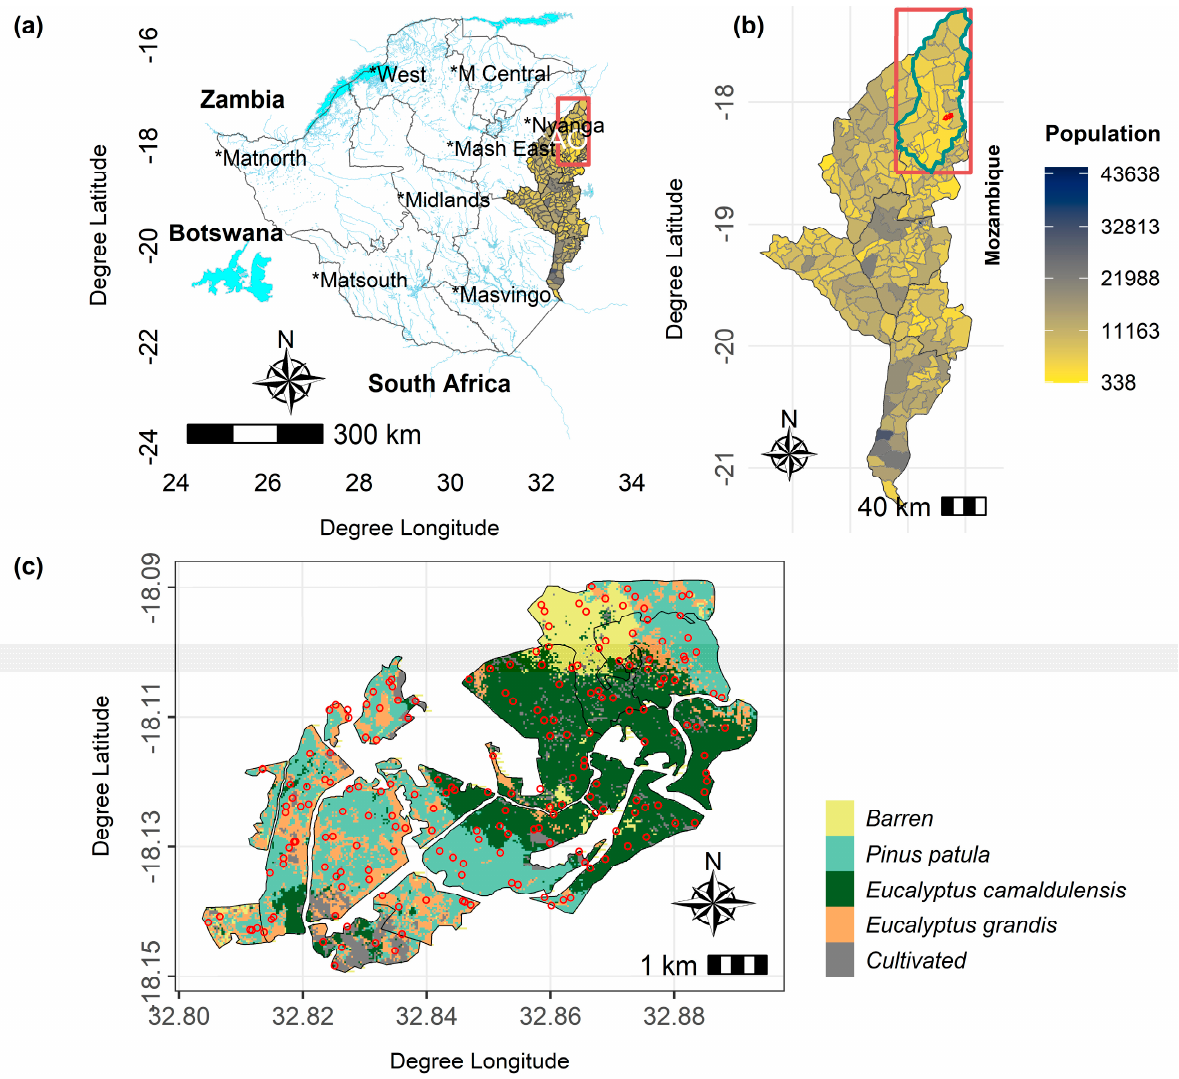
Figure 1. Study map showing ( a ) location of the province where samples for the study were collected, ( b ) study area location within the sampled province, and ( c ) plantation forest species distribution in the area of interest (AOI). * Shows provincial names.